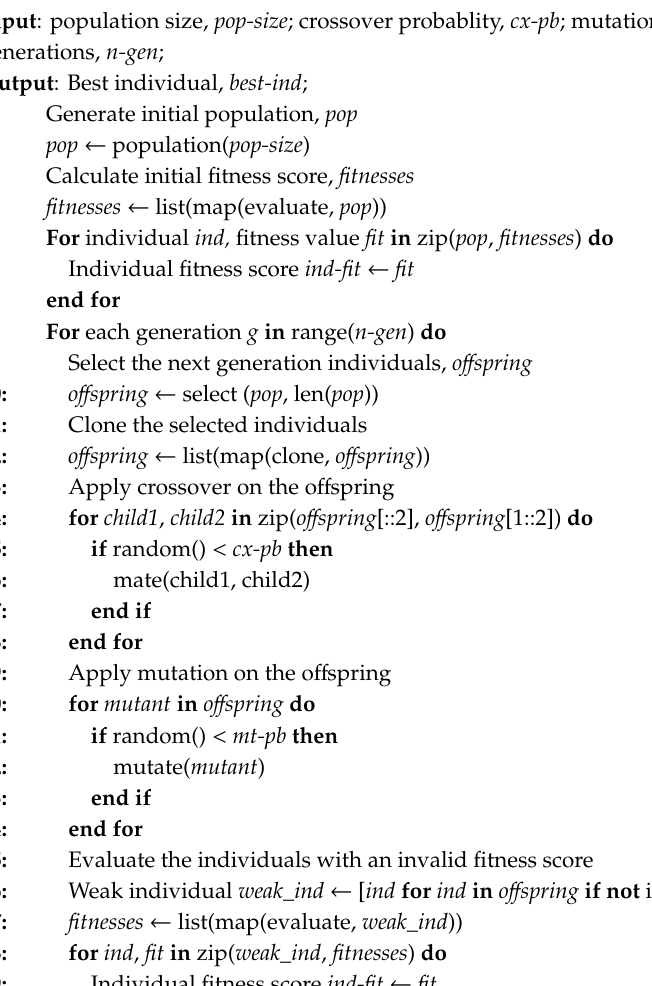
Algorithm 1. Genetic Algorithms (GA)-based feature selection